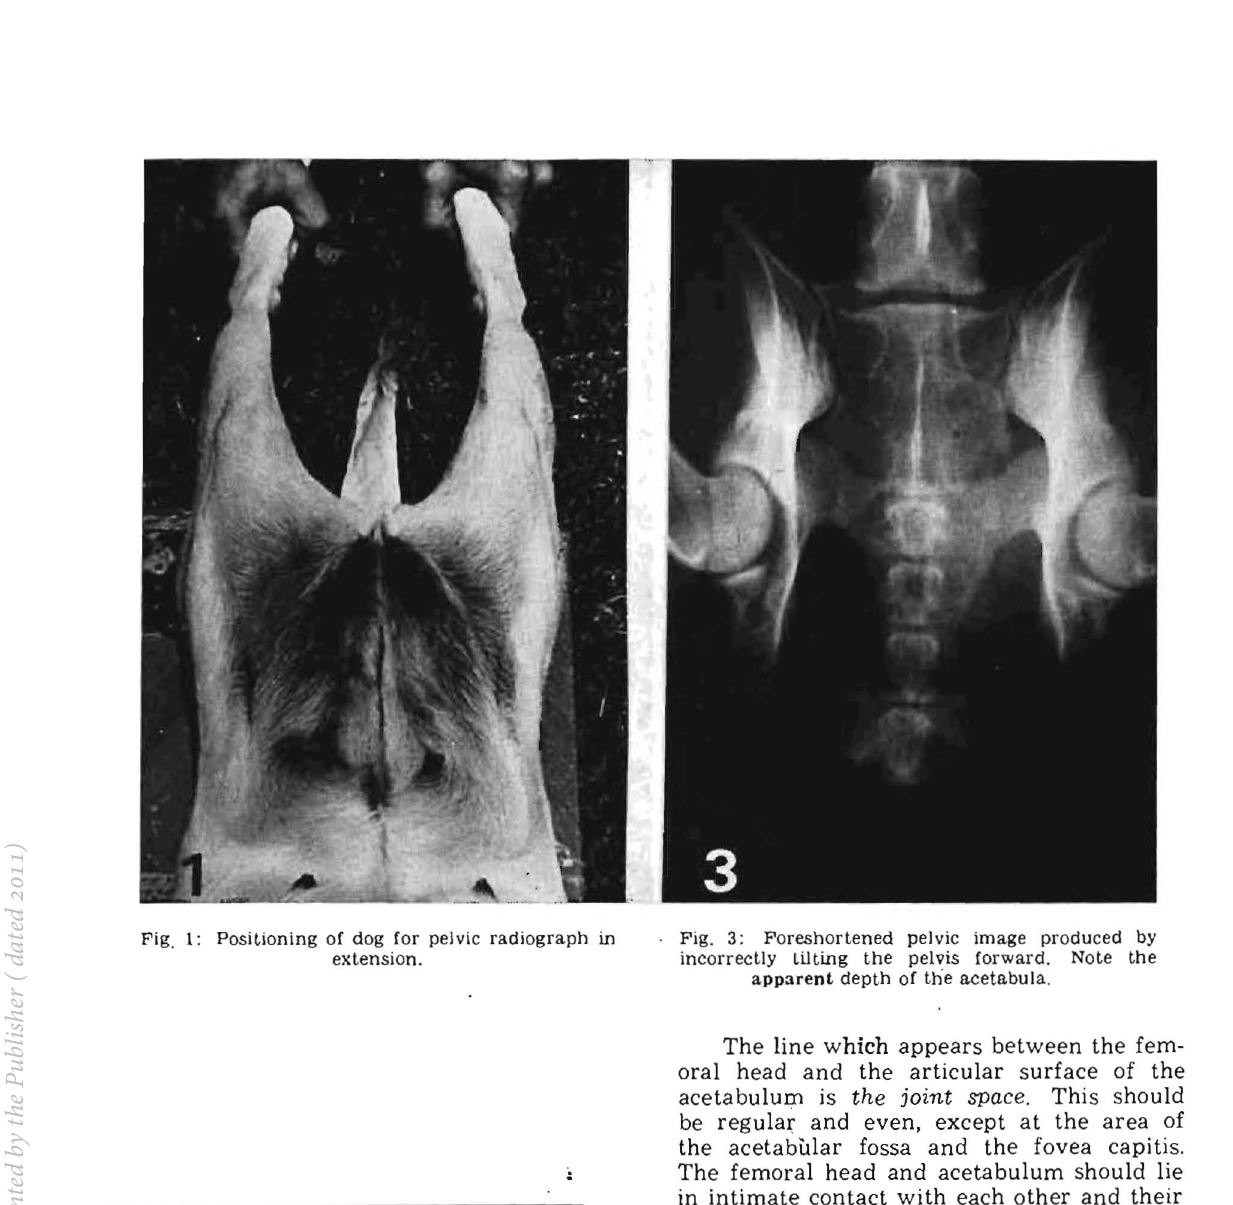
Fig. 3: Foreshortened pelvic image produced by Fig. 1: Posi~ioning of dog for pelvic radiograph in incorrectly lilting the pelvis forward. Note the extension. apparent depth of the